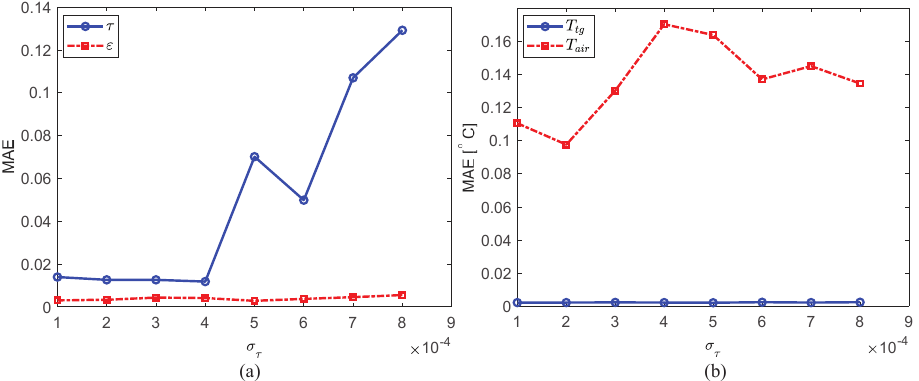
Figure 19. Parameter separation performance based on air temperature noise ( σ T and ( b ) MAE of T tg , T air .